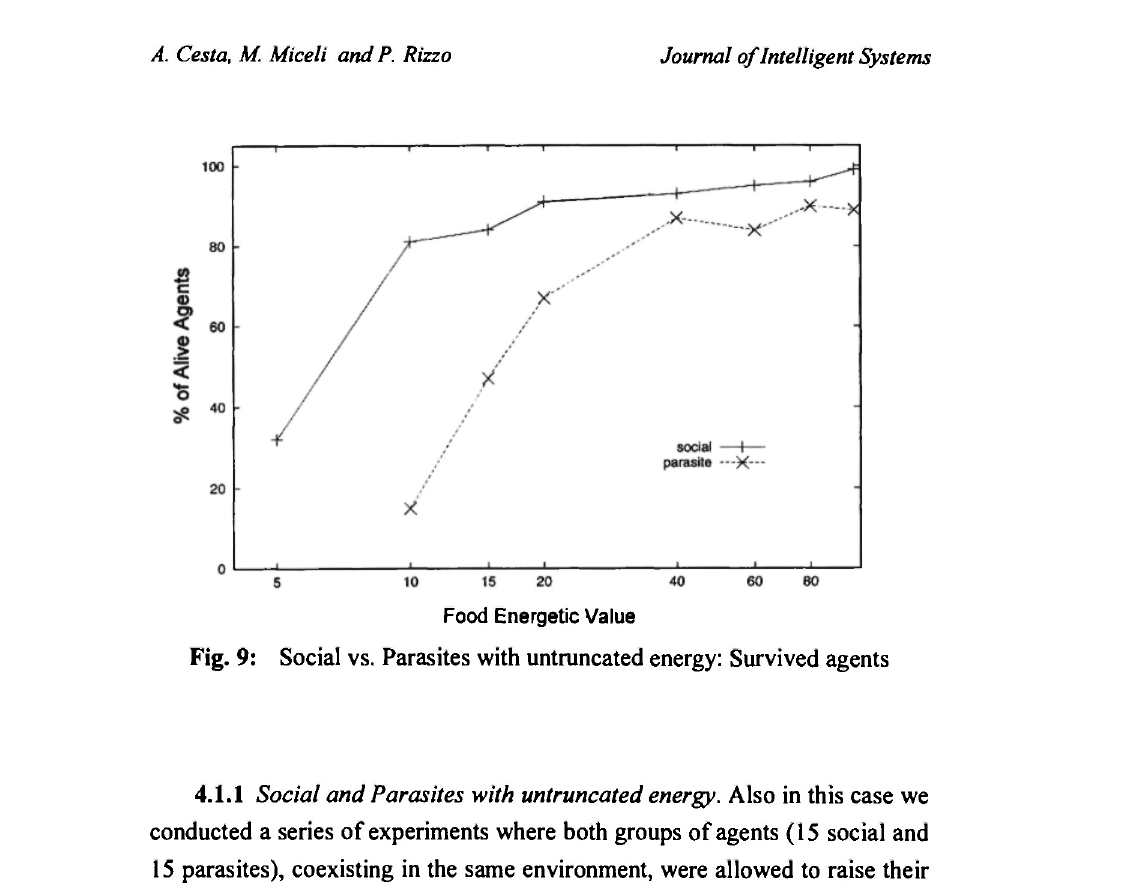
(b) the means of final energy in each group; and (c) the standard deviations in final energy in each